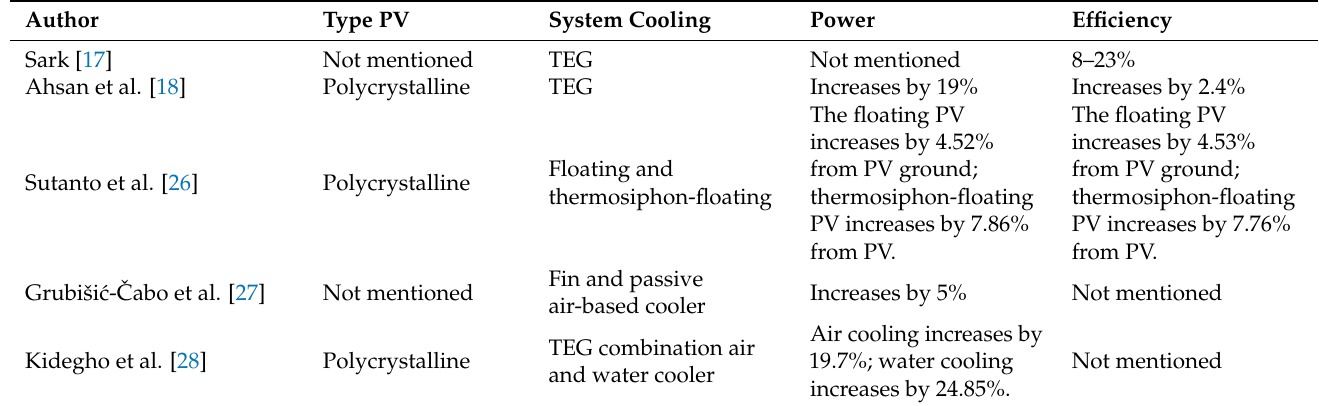
Table 1. Power and efficiency of some PV systems.